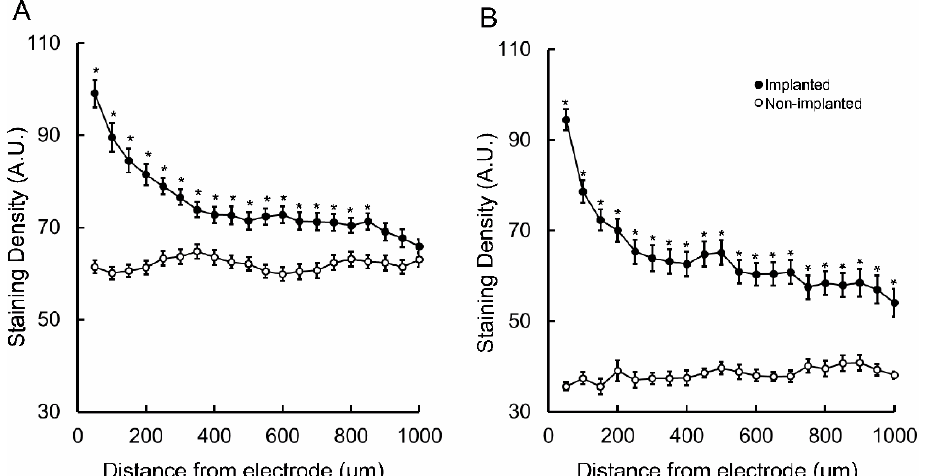
Figure 2. GFAP-immunostaining absolute density (mean ± SEM) within 1000 µ m from the microelectrode tracks and within correspondent non-implanted regions. ( A ) acutely- and chronically- implanted ( B ) sections. Asterisks indicate statistically significant difference relative to respective not-implanted region p < 0.05. A.U.: arbitrary units.